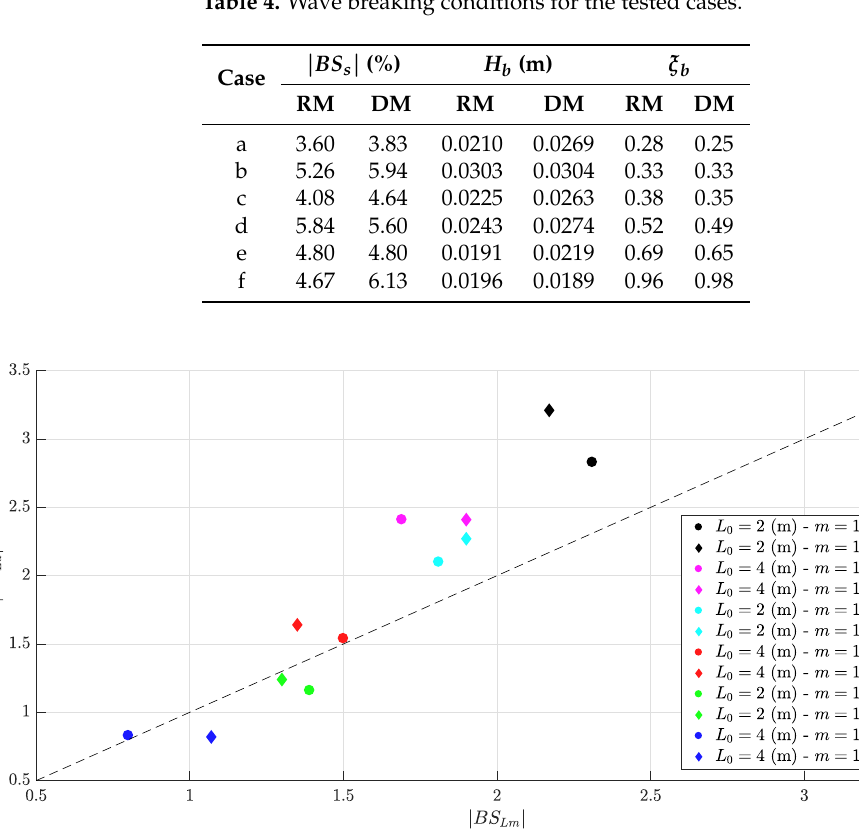
Figure 14. Comparison between the measured and empirical distance of the breaking point from the shore over the